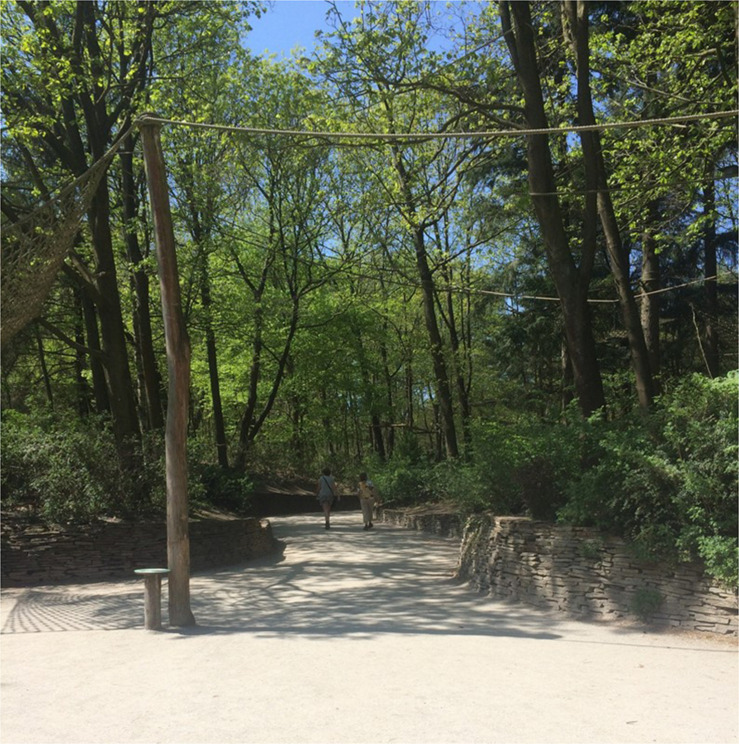
Observation area.